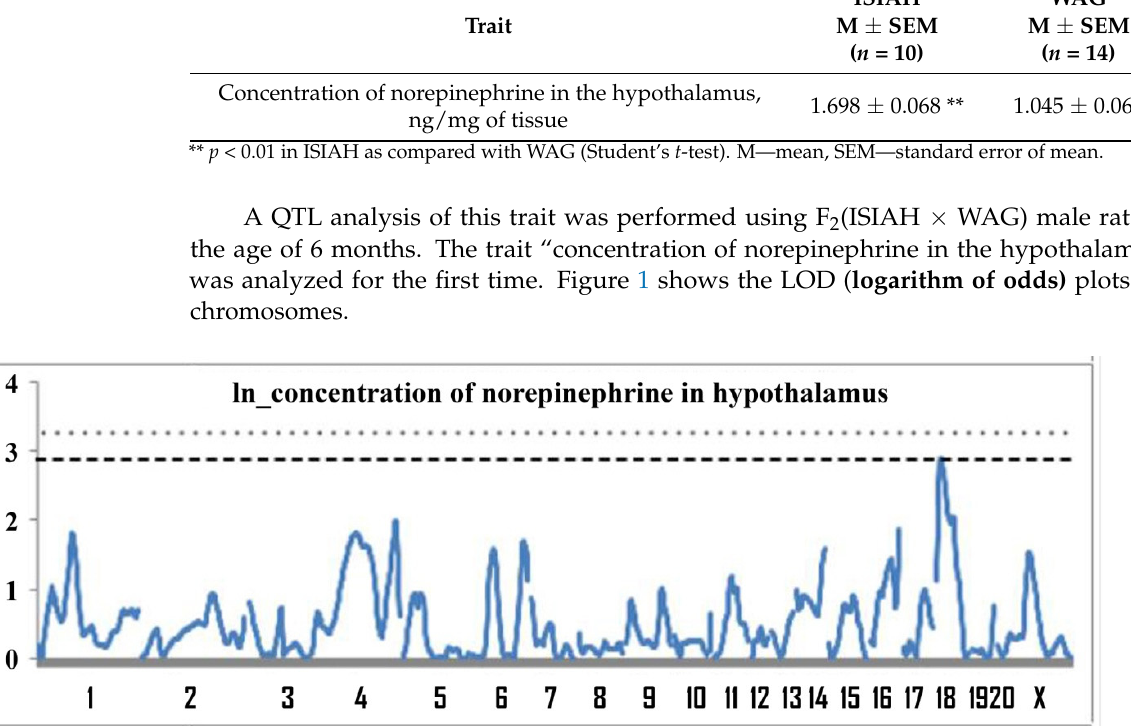
ISIAH WAG M ± SEM M ± SEM WAG ISIAH M ± SEM M ± SEM (n = 10) (n = 14) ( n = 14) ( n = 10) 1.045 ± 1.698 ± 0.068 ** 0.068 1.698 ± 0.068 ** 1.045 ± 0.068